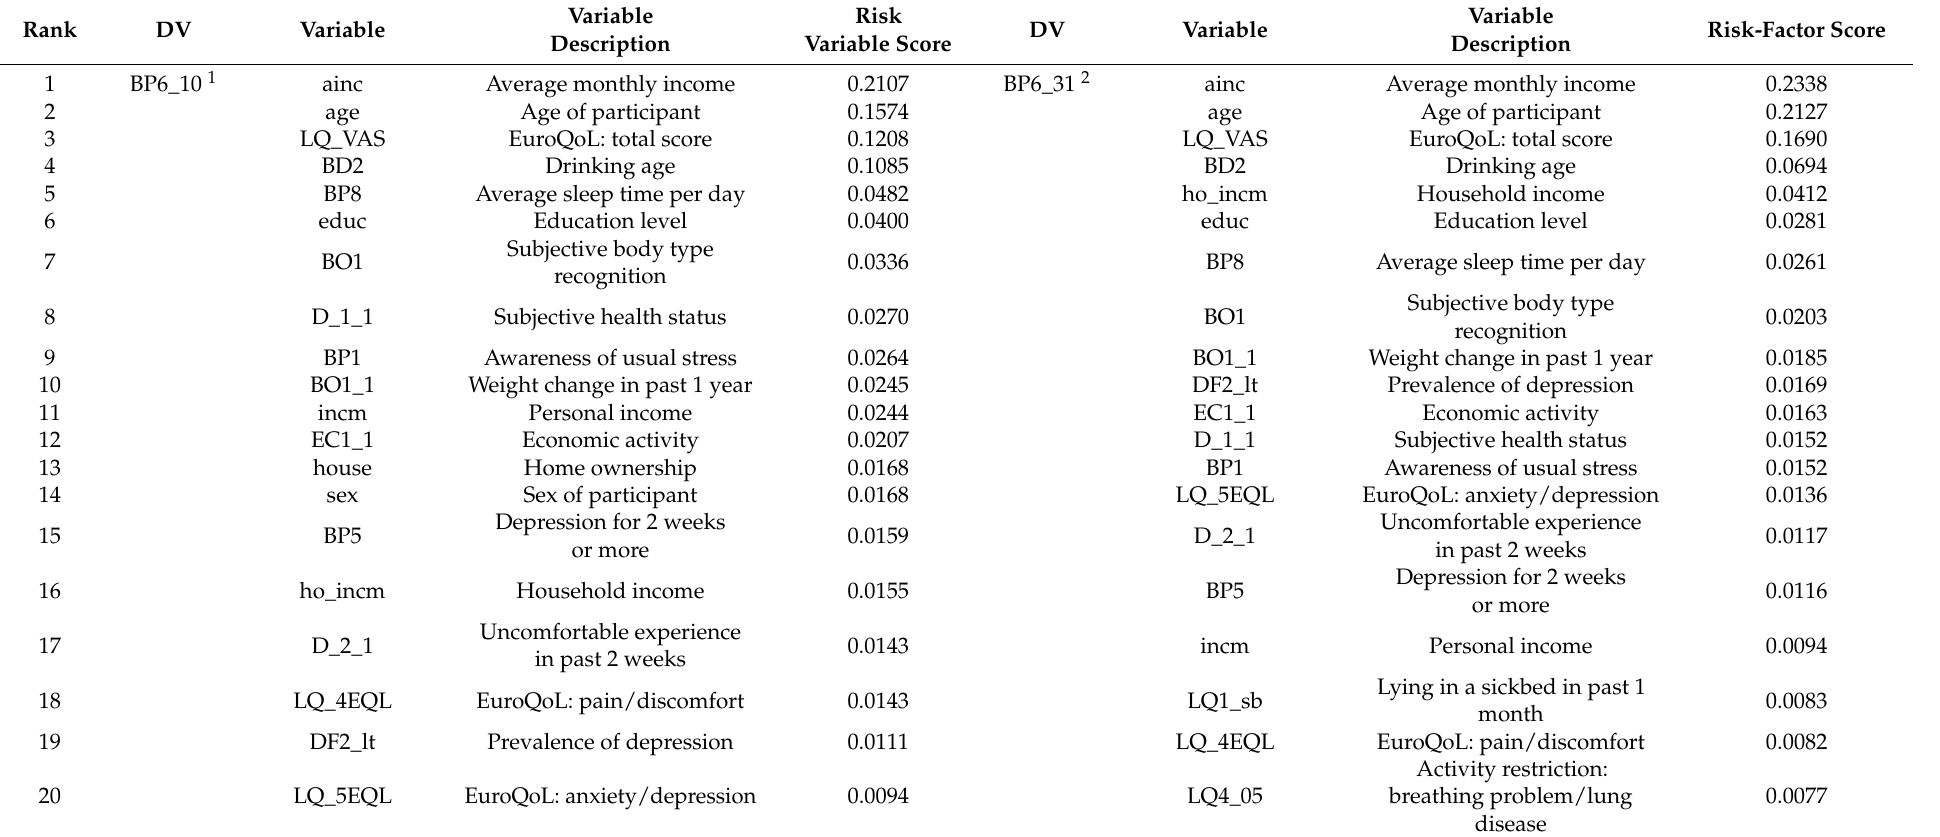
Table 11. Important features and risk-factor score in the yearly dataset condition